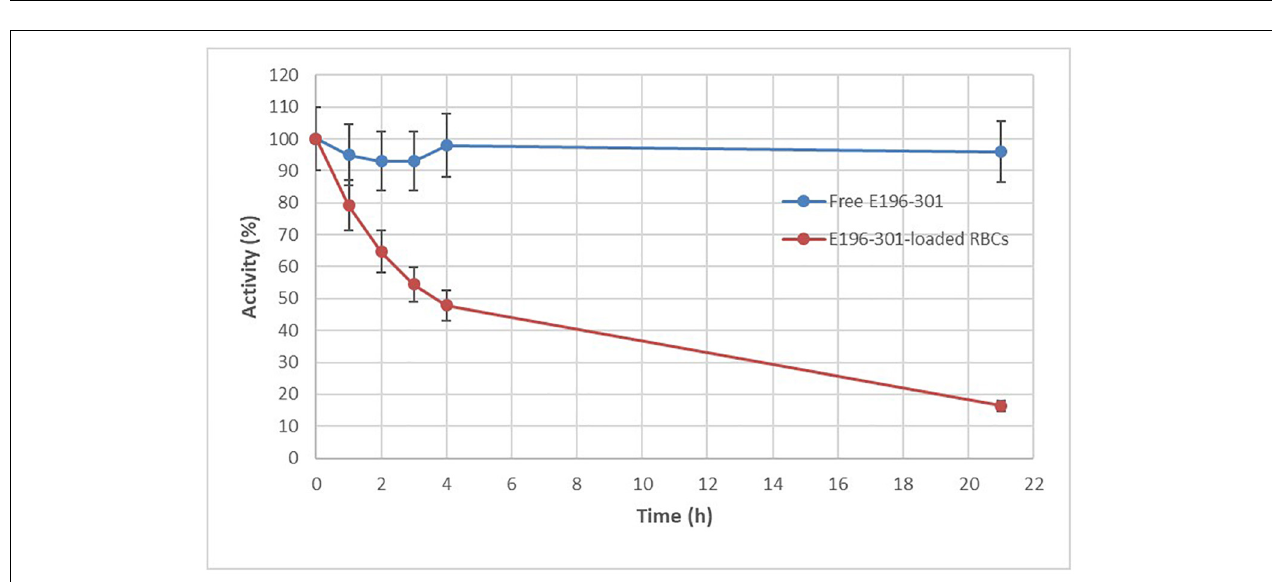
FIGURE 3 | Stability comparison between RBP 8000 and E196-301. In vitro stability of RBP 8000 and 196-301 at 37 ◦ C in PBS, pH 7.2. Free enzymes were tested at 10 ± 1 and 15 ± 1 IU/ml, respectively. All experiments were in duplicate that agree within 7.5%. Results are mean ± SD of three different experiments. All values were significantly different ( p < 0.005).